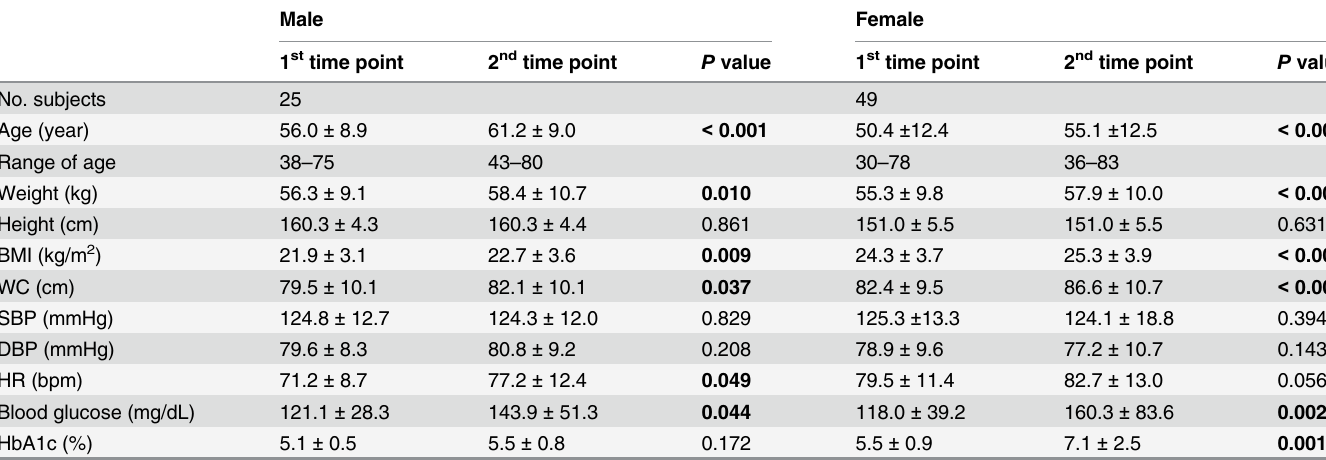
Data are mean ± SD or number Comparison of data collected fi rst (in 2007 and 2008) with data collected second (in 2012 and 2013), using the Wilcoxon signed-rank test for paired comparisons. Signi fi cant P values ( < 0.05) are in